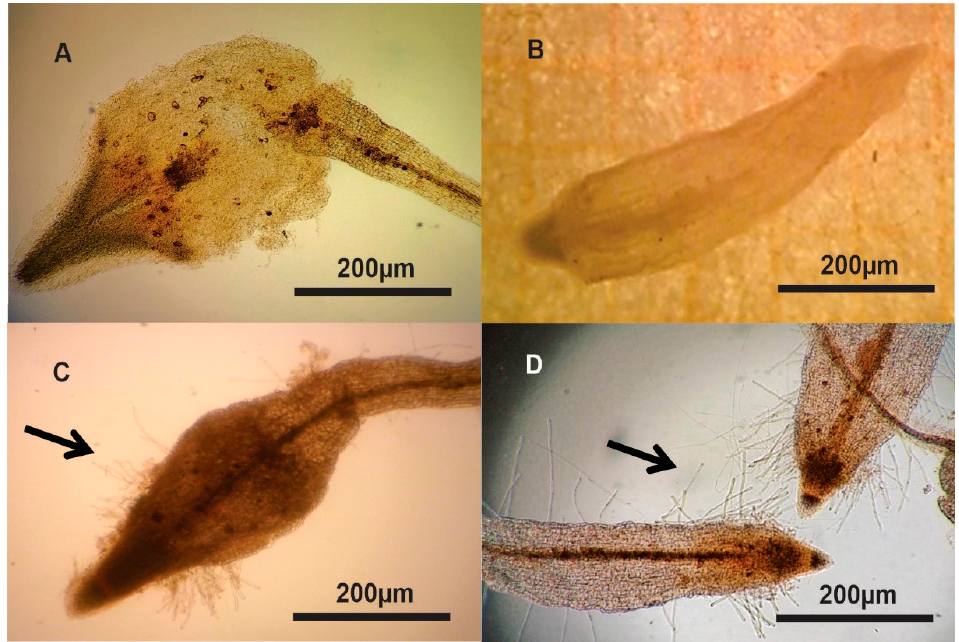
Figure 4. Surface of nontransformed ( A , B ) and agrotransformed somatic embryos in the oblong ( A , C ) and scutellar ( B , D ) stages established from the embryogenic rhizoclone after 28 days of transfection with the K599 A. rhizogenes strain. Note the higher abundance of hairy roots (arrows) on the apical tips of the agrotransformed tissue ( C , D ) compared with the absence of adventitious roots on the nontransformed tissue ( A , B ). Table 1. Effects of the Agrobacterium rhizogenes strain on the transformation, survival, and hairy density of Typha domingensis somatic embryos.